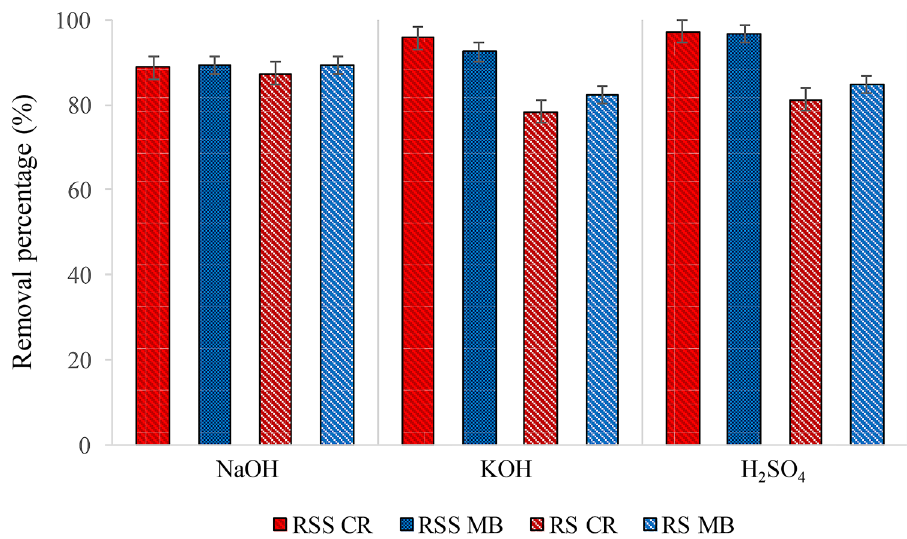
Figure 7. Adsorption removal study using various activating agents for MB and CR using